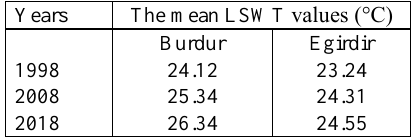
Table 3 . The mean LSWT values for the years 1998, 2008 and 2018.